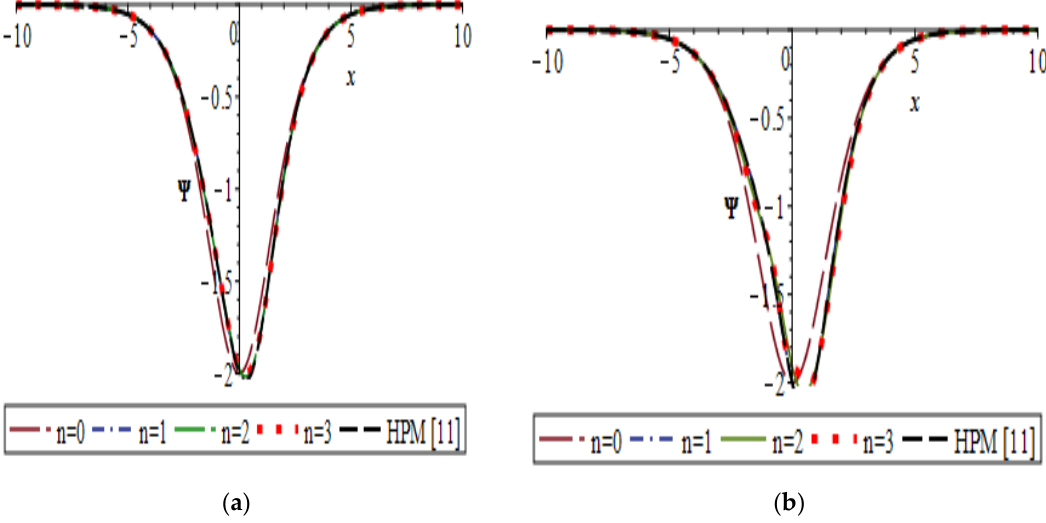
Figure 6. Comparison plots of ψ FRDTM and ψ HPM of modified Camassa–Holm (mCH) equation for − 10 ≤ x ≤ 10. ( a ) t = 0.05, α = 1; ( b ) t = 0.1, α =